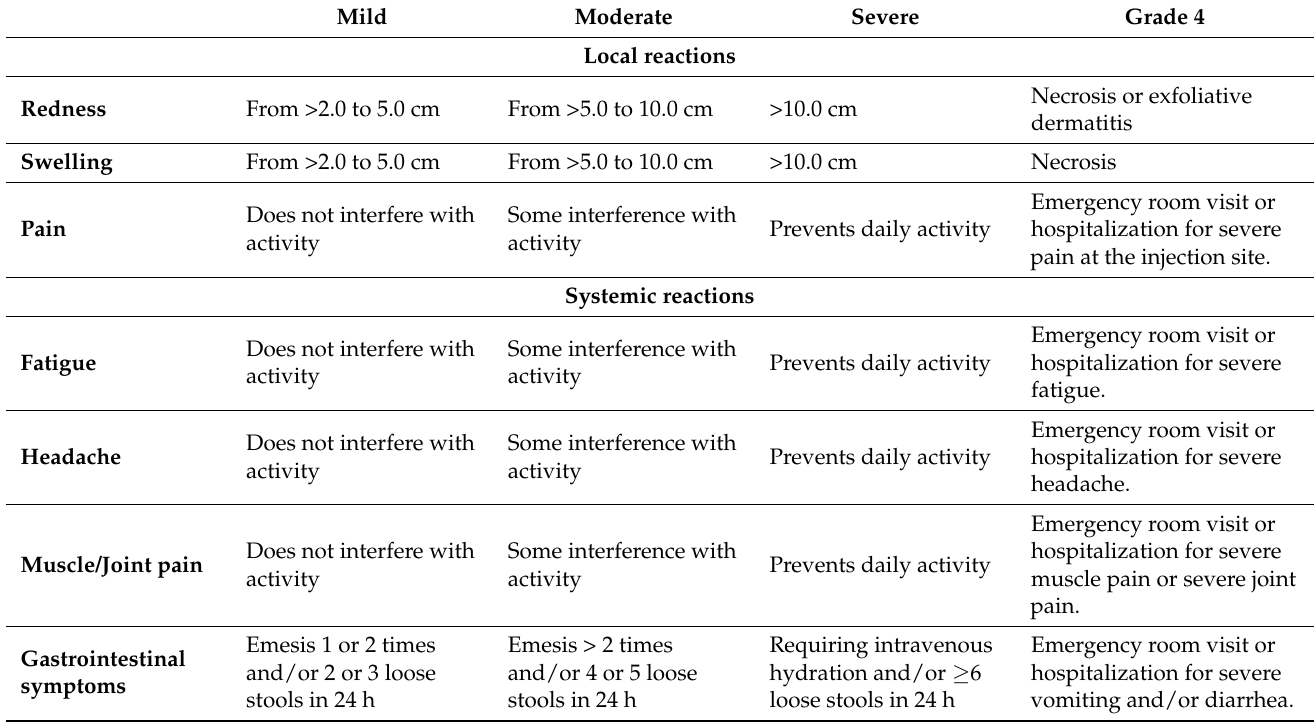
Table A1. Classification of the severity of local and systemic adverse reactions following